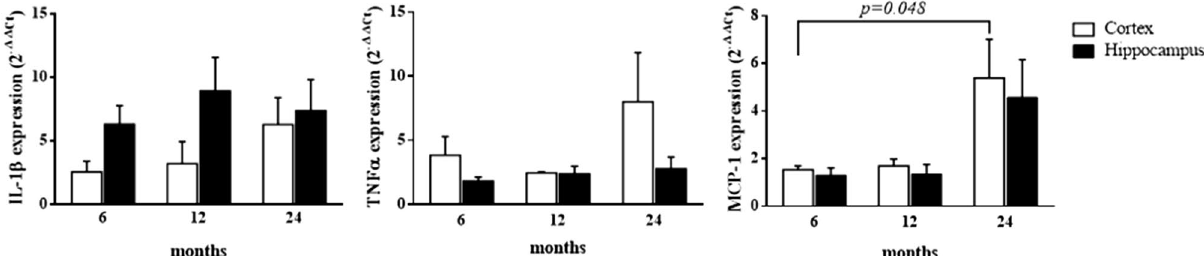
Figure 5. Cytokine/chemokine expression levels in cortex and hippocampus at different postnatal ages in AD (APPswe/PS1dE9) Tg mice with respect to age-matched WT mice. Bar plots graphically depict the mean and SEM of pro-inflammatory cytokine/chemokine gene expression levels in cortex and hippocampus at different postnatal ages. Statistically significant p-values, after adjustment according to the FDR methods, are graphically depicted too.